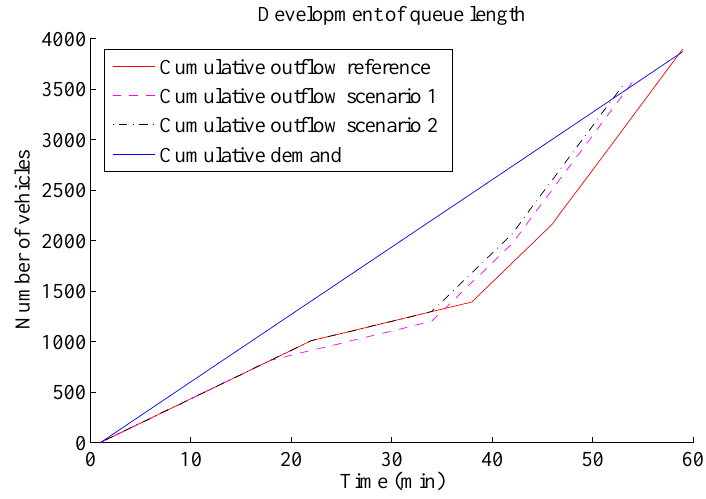
Figure 7. The delays for different